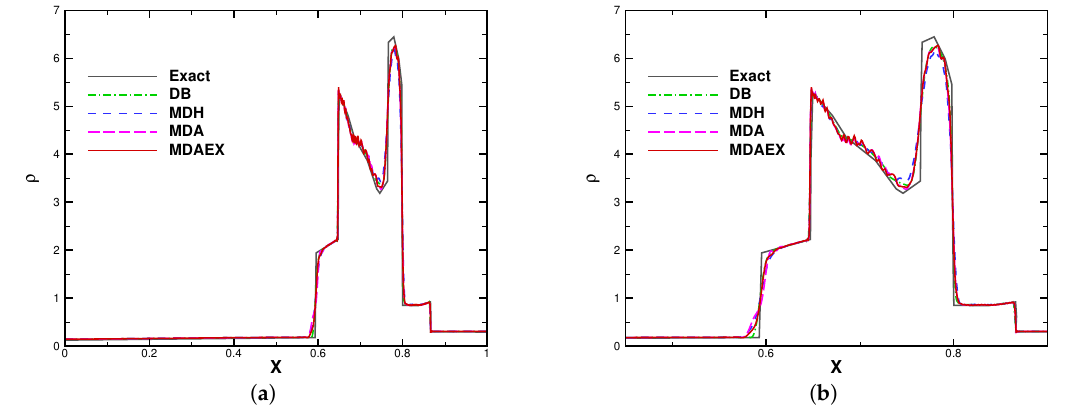
Figure 16. Density solution for the blast wave problem with 300 elements at t = 0.038, P 4. ( a ) Overview; ( b ) zoomed in results.